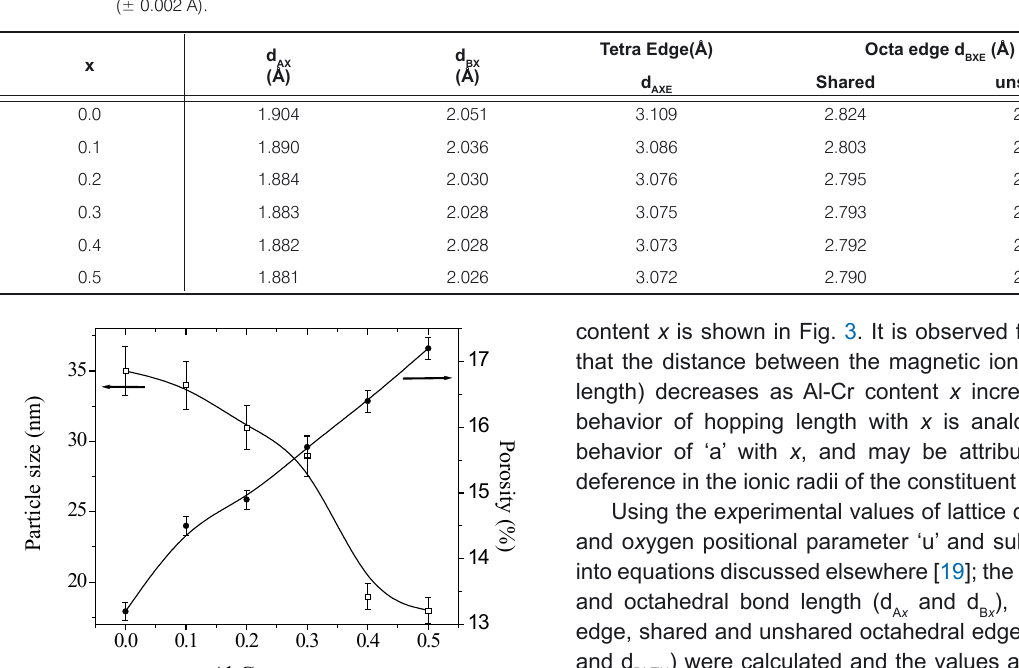
), Tetra edge (d ) and octaedge (d Bx AxE